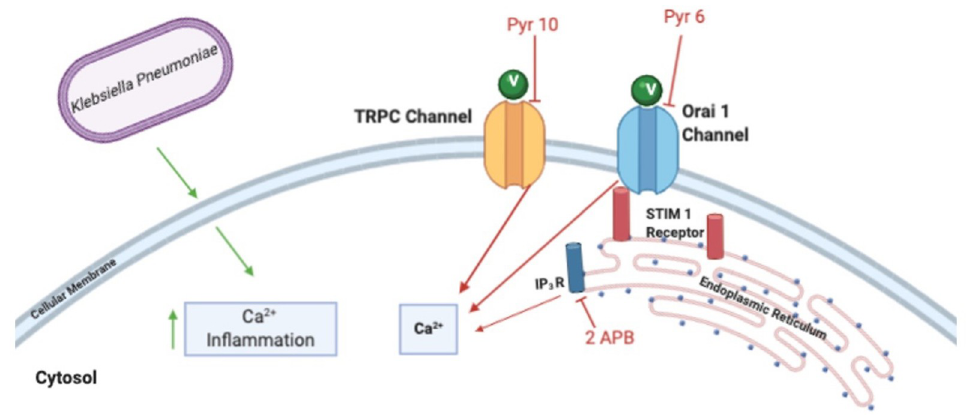
Fig 4. Schematic representation of the major receptor pathways involved in Ca 2+ increases due to E-cig/vape exposure. The Ca 2+ channel antagonists Pyr6, Pyr10 and 2-APB were utilized to assess their effectiveness in blocking and/or reducing vaping-associated inflammation. Pyr10, Pyr6 and 2-APB inhibit Transient Receptor Protein (TRP) channels, Orai1/STIM1 and the inositol trisphosphate receptor (IP 3 R), respectively. K . pneumoniae infection also elicits an inflammatory response and is also likely to alter Ca 2+ homeostasis. V =